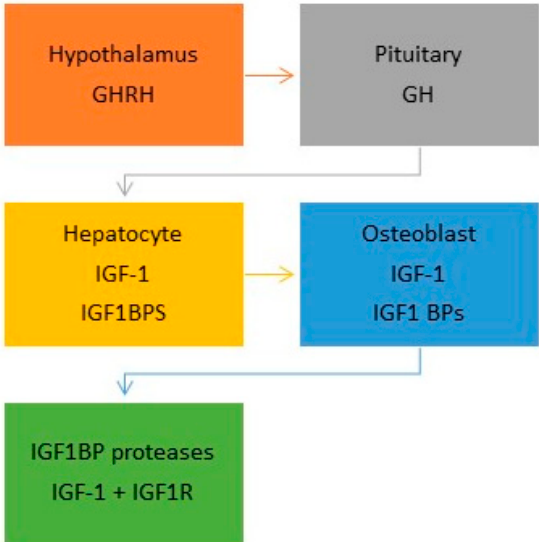
Figure 3. The somatotropic axis. The hypothalamus produces growth hormone releasing hormone stimulating the pituitary to release growth hormone which acts on hepatocytes to produce insulin-like growth factor-1 and some of its binding proteins. Circulating IGF-1 reaches the bone matrix where it and some of its binding proteins are produced primarily by osteoblasts in an autocrine / paracrine manner. Released from its binding proteins by proteases, IGF-1 binds to its receptor IGF1R initiating its radial growth effects on osteoblasts and, with the aid of growth hormone, its linear growth effects on chondrocytes.